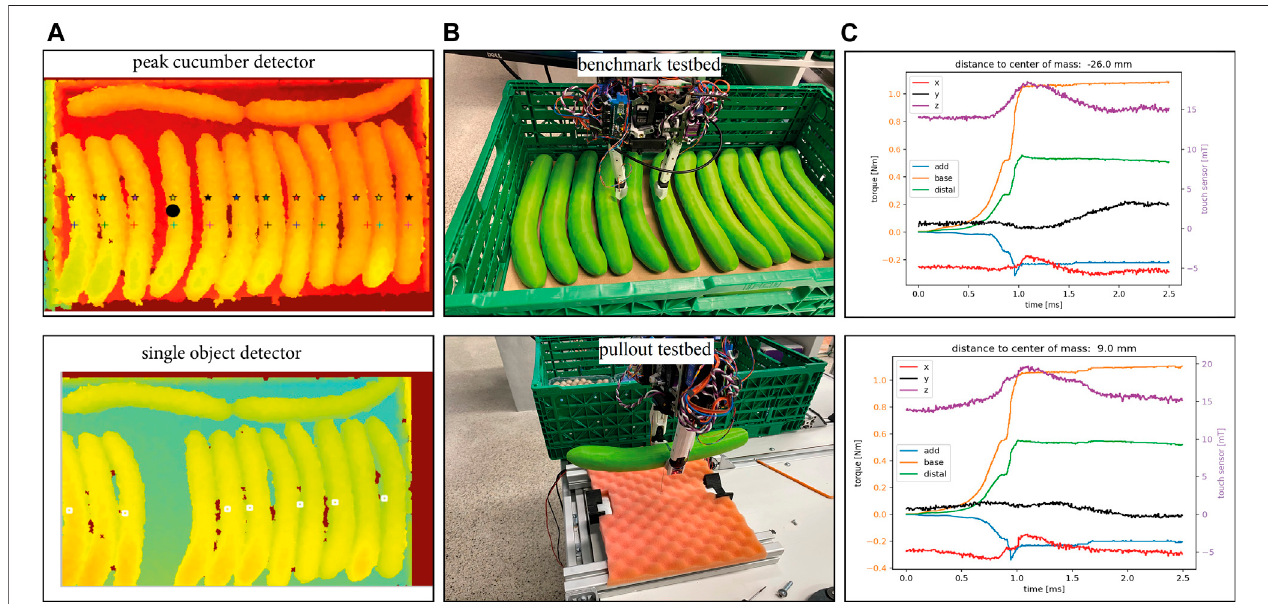
FIGURE 13 | Scenario C 3. (A) Vision algorithms. (B) benchmark testbed and pullout testbed. (C) Output of the MLX90395 sensor during pullout tests, where the y-component (black line) clearly signals if a cucumber rotates inside the hand. The orange, green, and blue lines (with corresponding scale in the left y -axis) show the fi ngerjointtorques;theobjectrotationcannotbedetectedbythem,astheydonotchangeaftertherotationstarts.Thered,blackandmagentalines(withcorresponding scale in the right y-axis) show the response of the tactile sensor in the three directions x, y and